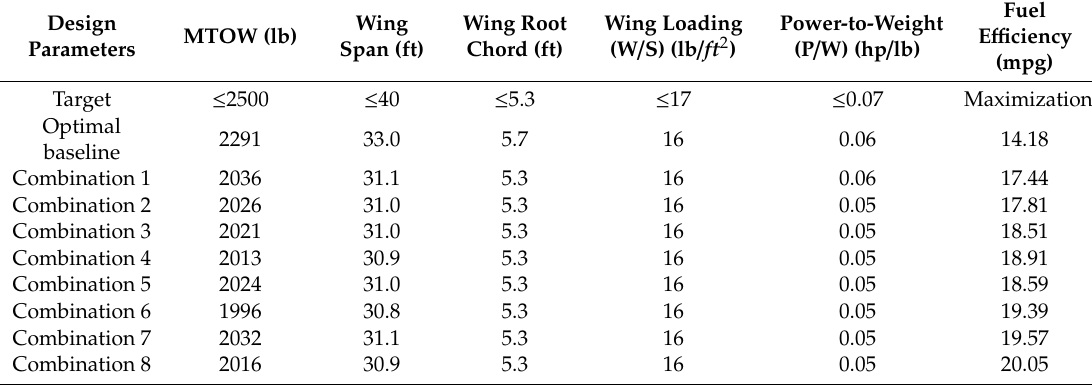
Table 14. Alternative design parameters satisfying all requirements.